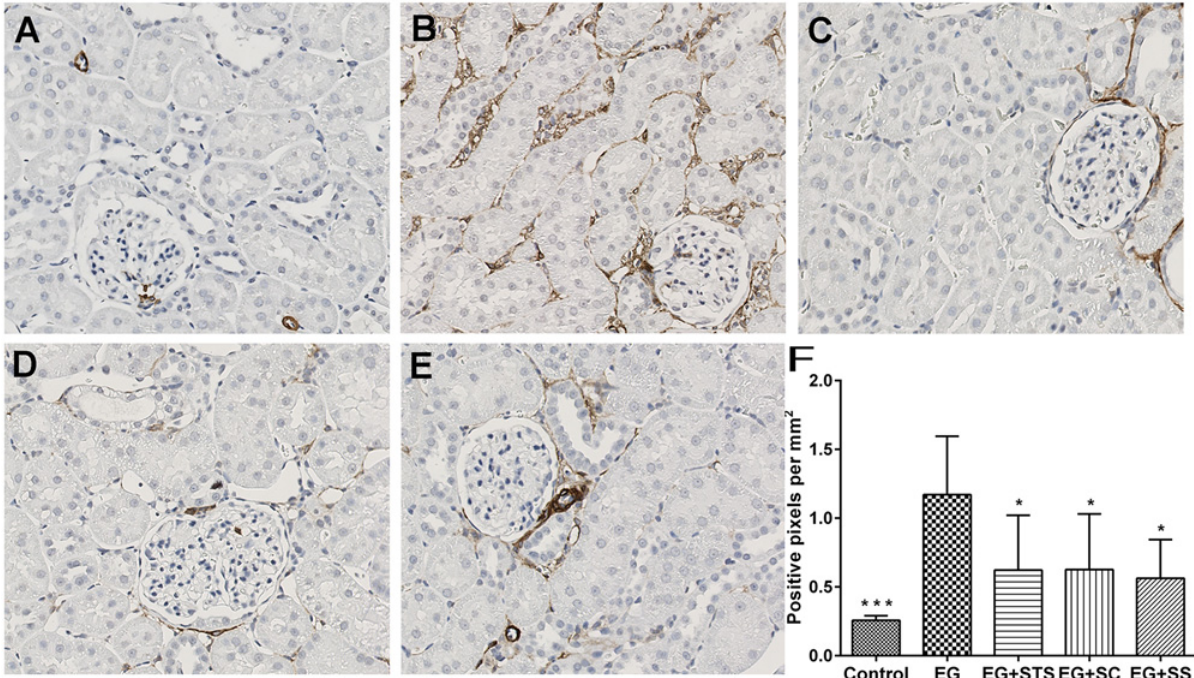
Fig 3. α -SMA stain of kidney tissue. The groups are (A) control, (B) EG-exposed, (C) EG+STS-exposed, (D) EG+SC-exposed, (E) EG+SS-exposed animals. The α -SMA stain was markedly increased in EG-exposed animals but decreased in all treatment groups. The significance levels are with reference to the EG group. The data are means ± SD from 7 – 8 animals per group. * p < 0.05, ** p < 0.01, *** p < 0.001.